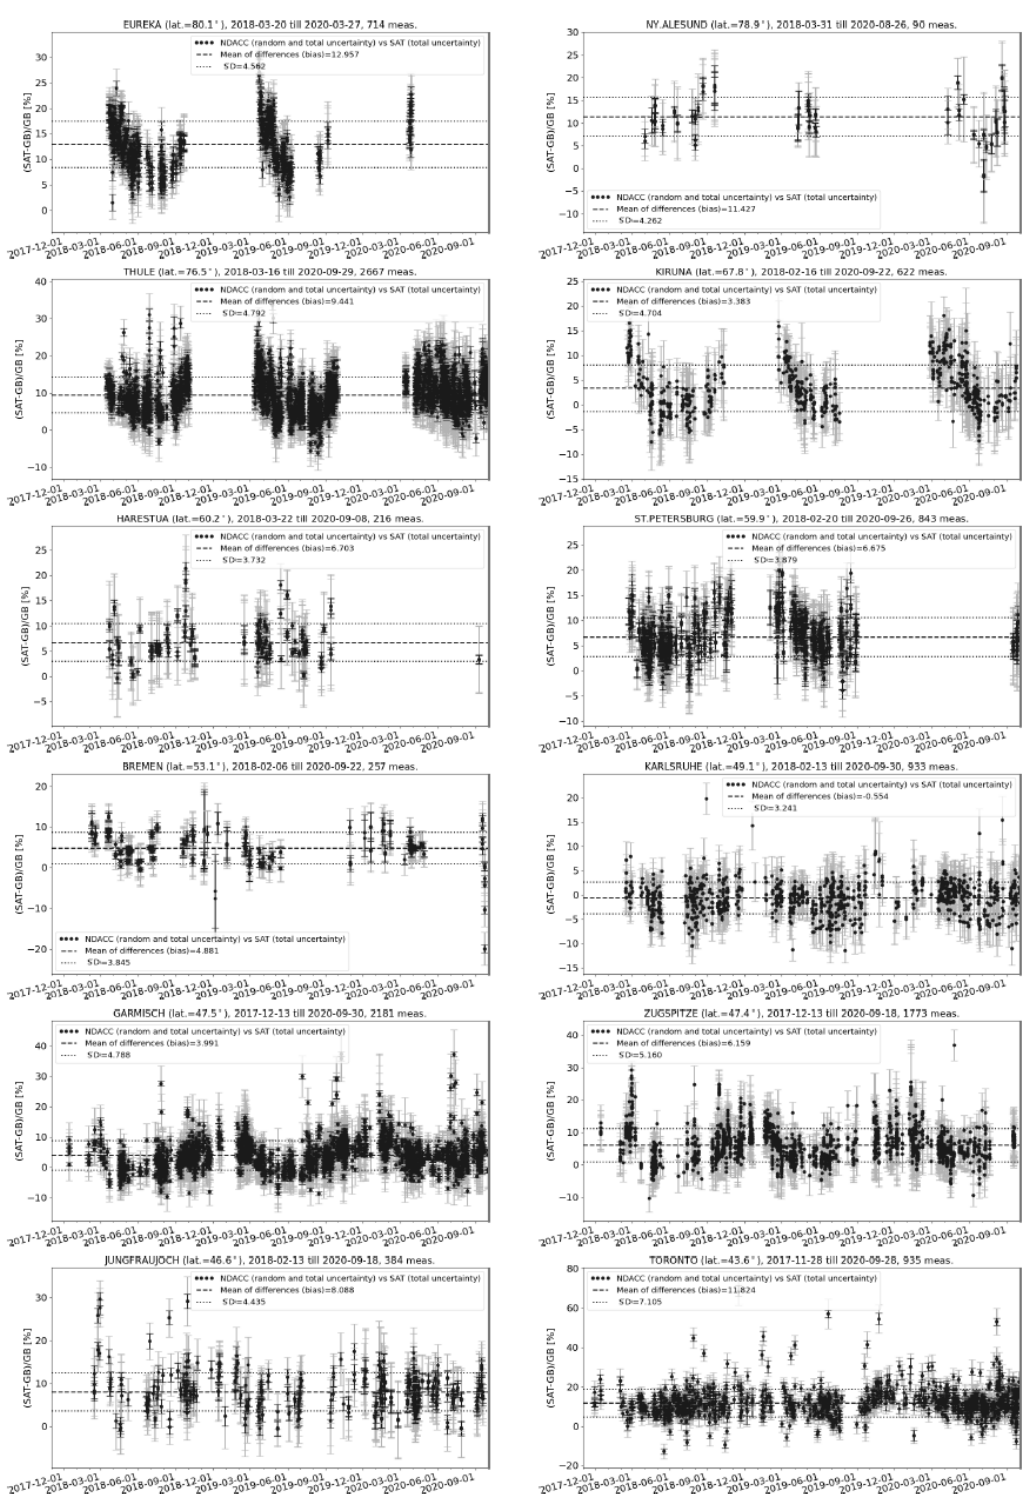
Figure 29. Relative difference ((satellite − ground-based)/ground-based) of CO column time series for all co-located S5P data and NDACC data smoothed with S5P a priori and additionally smoothed with the S5P column-averaging kernel as the reference data at each site ordered with decreasing latitude as in Fig. 27. Spatial co-location with radius of 50km and time of ± 3h around the satellite overpass was